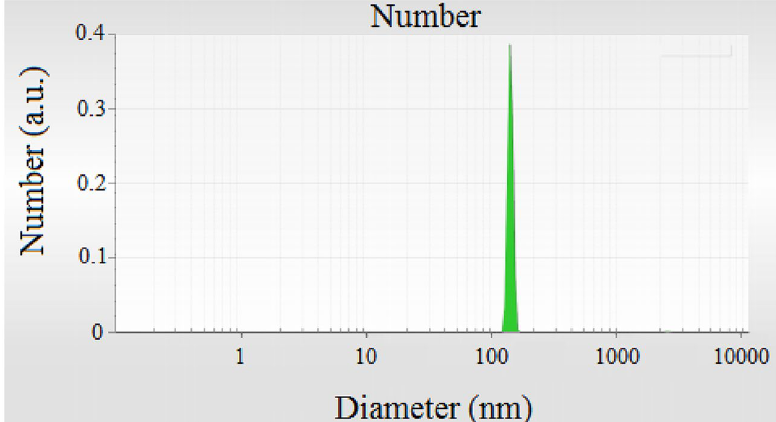
Figure 3. DLS analysis of